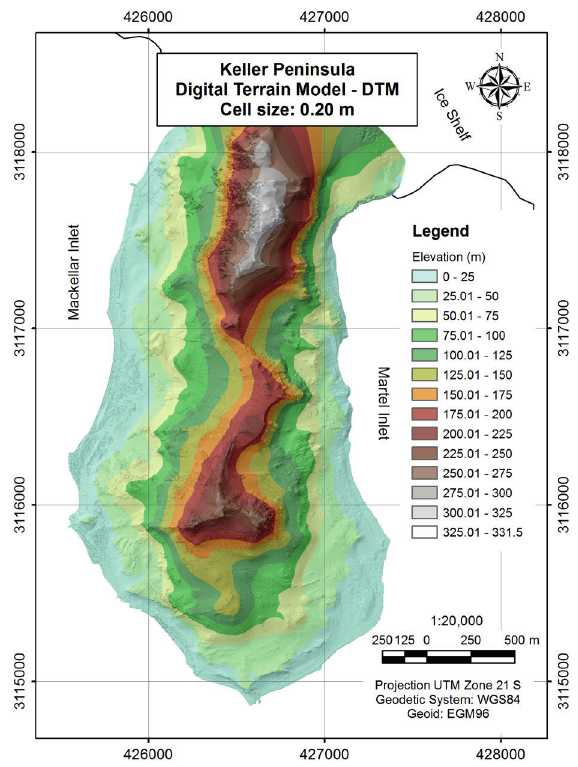
Figure 5 - Digital Terrain Model of Keller